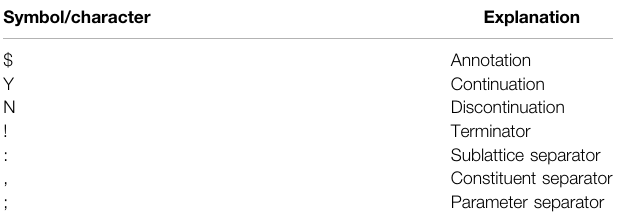
TABLE 1 | Explanation of some special